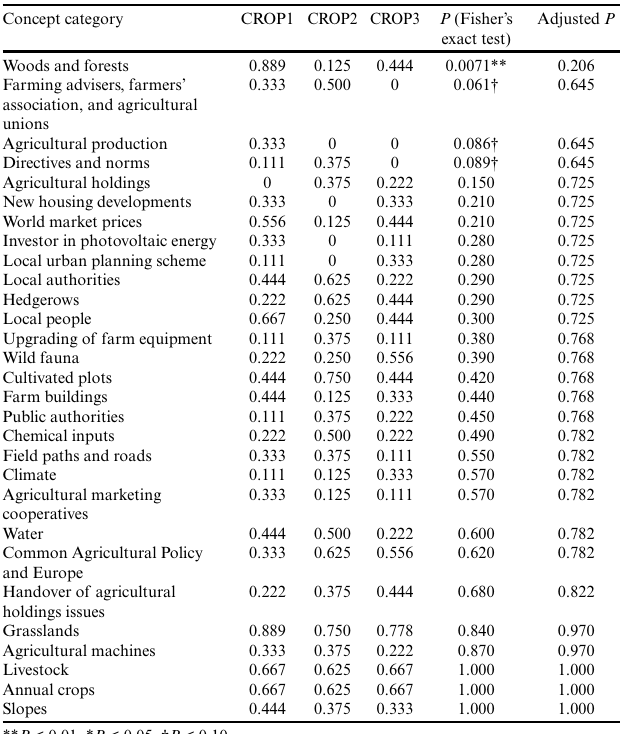
Table 4. Concepts tested during the comparative analysis of farmer groups based on types of cropland management practices (typology